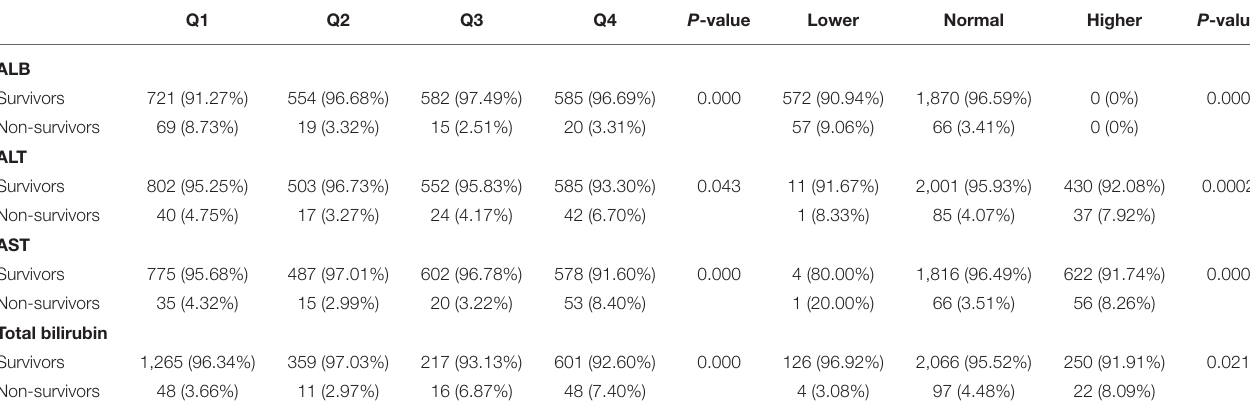
TABLE 4 | The relationship between ALB, ALT, AST, and total bilirubin with 90-day mortality.